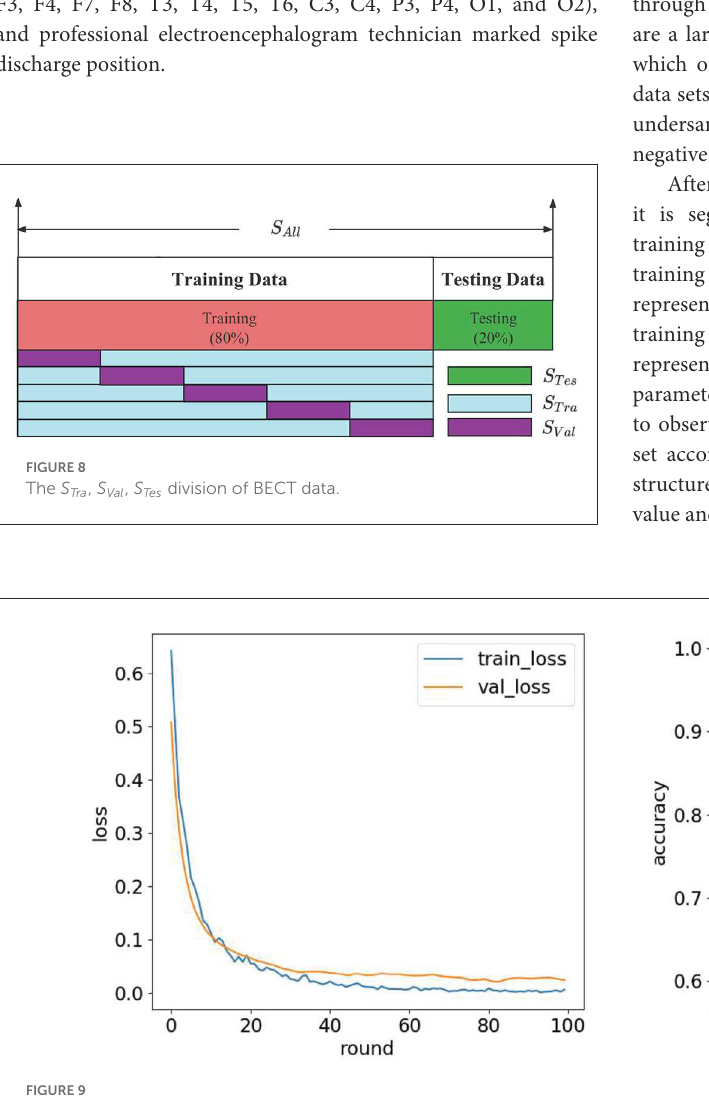
FIGURE9 Loss value and accuracy under different iterations.